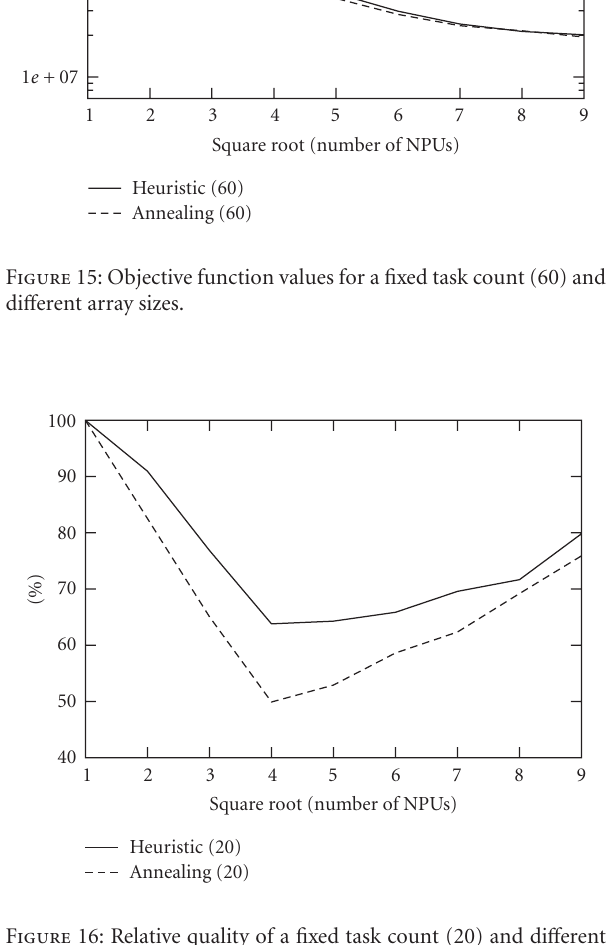
Figure 16: Relative quality of a fixed task count (20) and di ff erent array